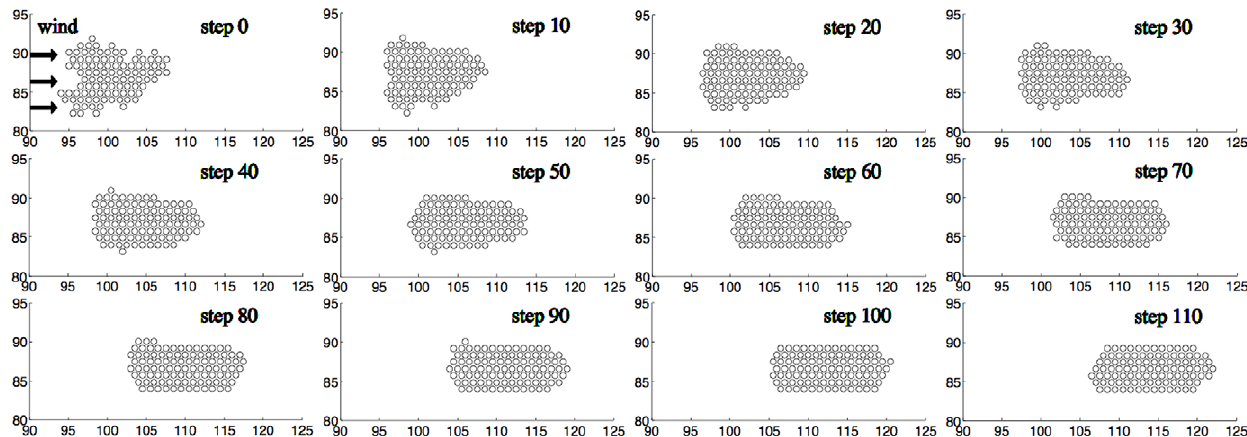
Figure 2. Time progression of a model huddle. Dynamics of a huddle according to our deterministic model, with parameters N =100 penguins, Pe =10, R =4. The wind is coming from the left side.